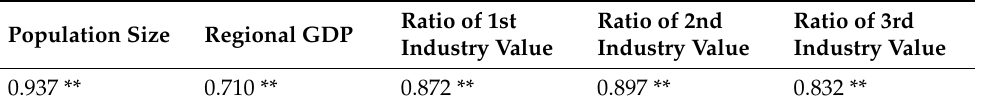
Table 3. The correlations between the total ozone and economic development of the Yangtze River Delta Urban Agglomerations from 2000 to